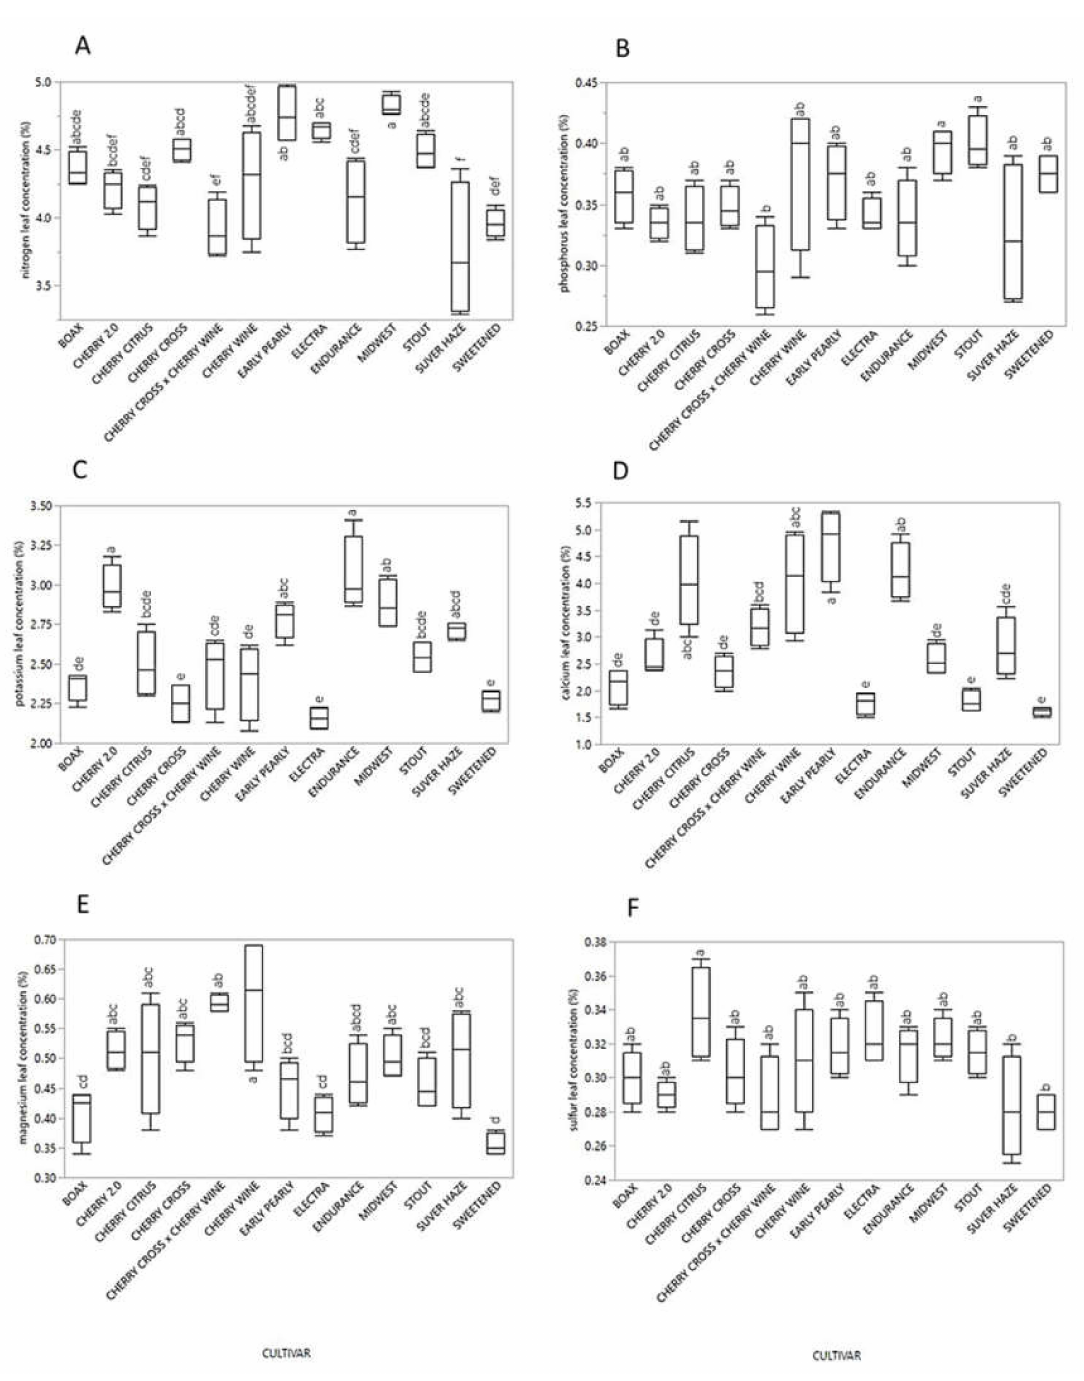
Figure 1. Leaf tissue macronutrient concentration ranges for thirteen greenhouse-propagated cannabidiol (CBD) hemp cultivars. Plants were 12 weeks-old and in a vegetative stage of development prior to the excision of initial cuttings for propagation. ( A ) nitrogen, ( B ) phosphorus, ( C ) potassium, ( D ) calcium, ( E ) magnesium, and ( F ) sulfur. Nutrient means that share similar lowercase letters within each graph are not significantly di ff erent from each other according to Tukey’s (HSD) Test at p >